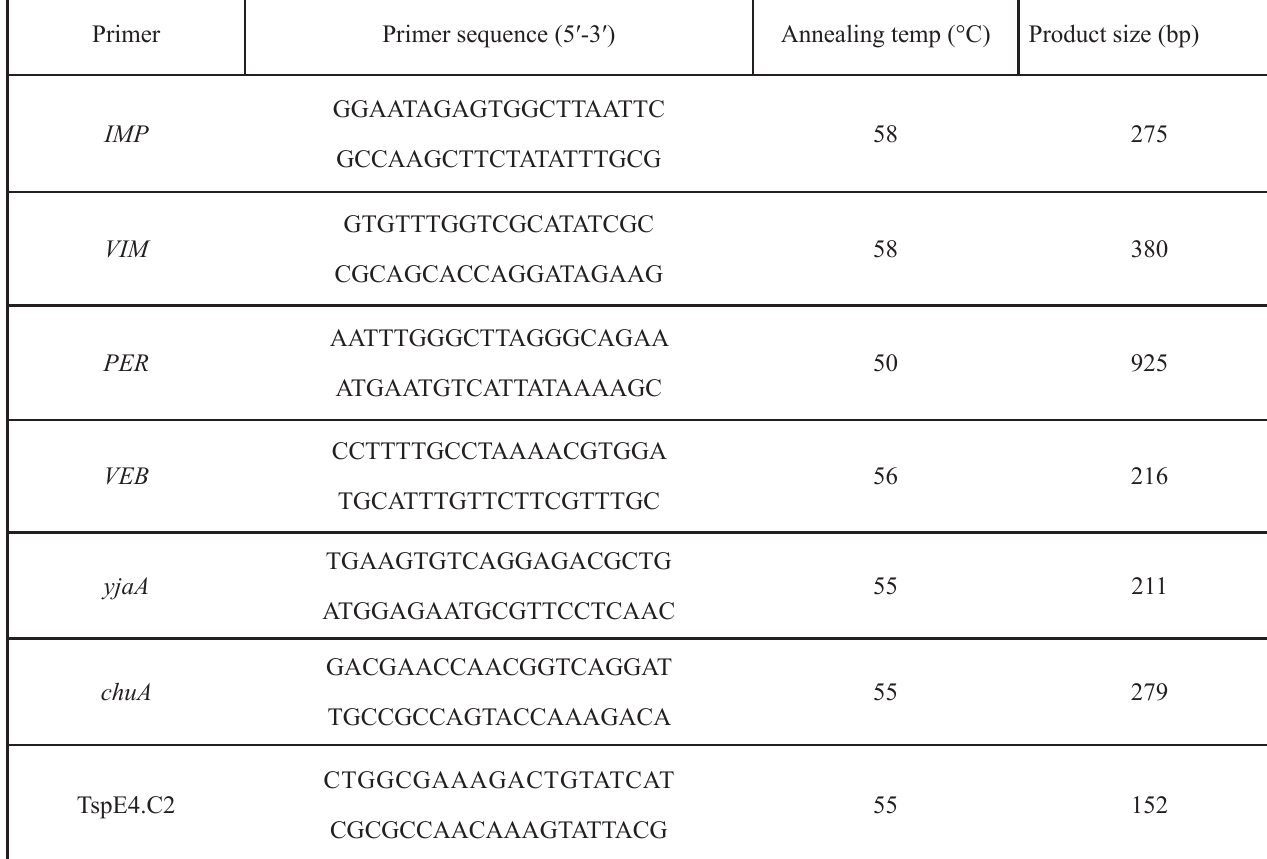
Table 1: Specific primers used in this study Primer Primer sequence